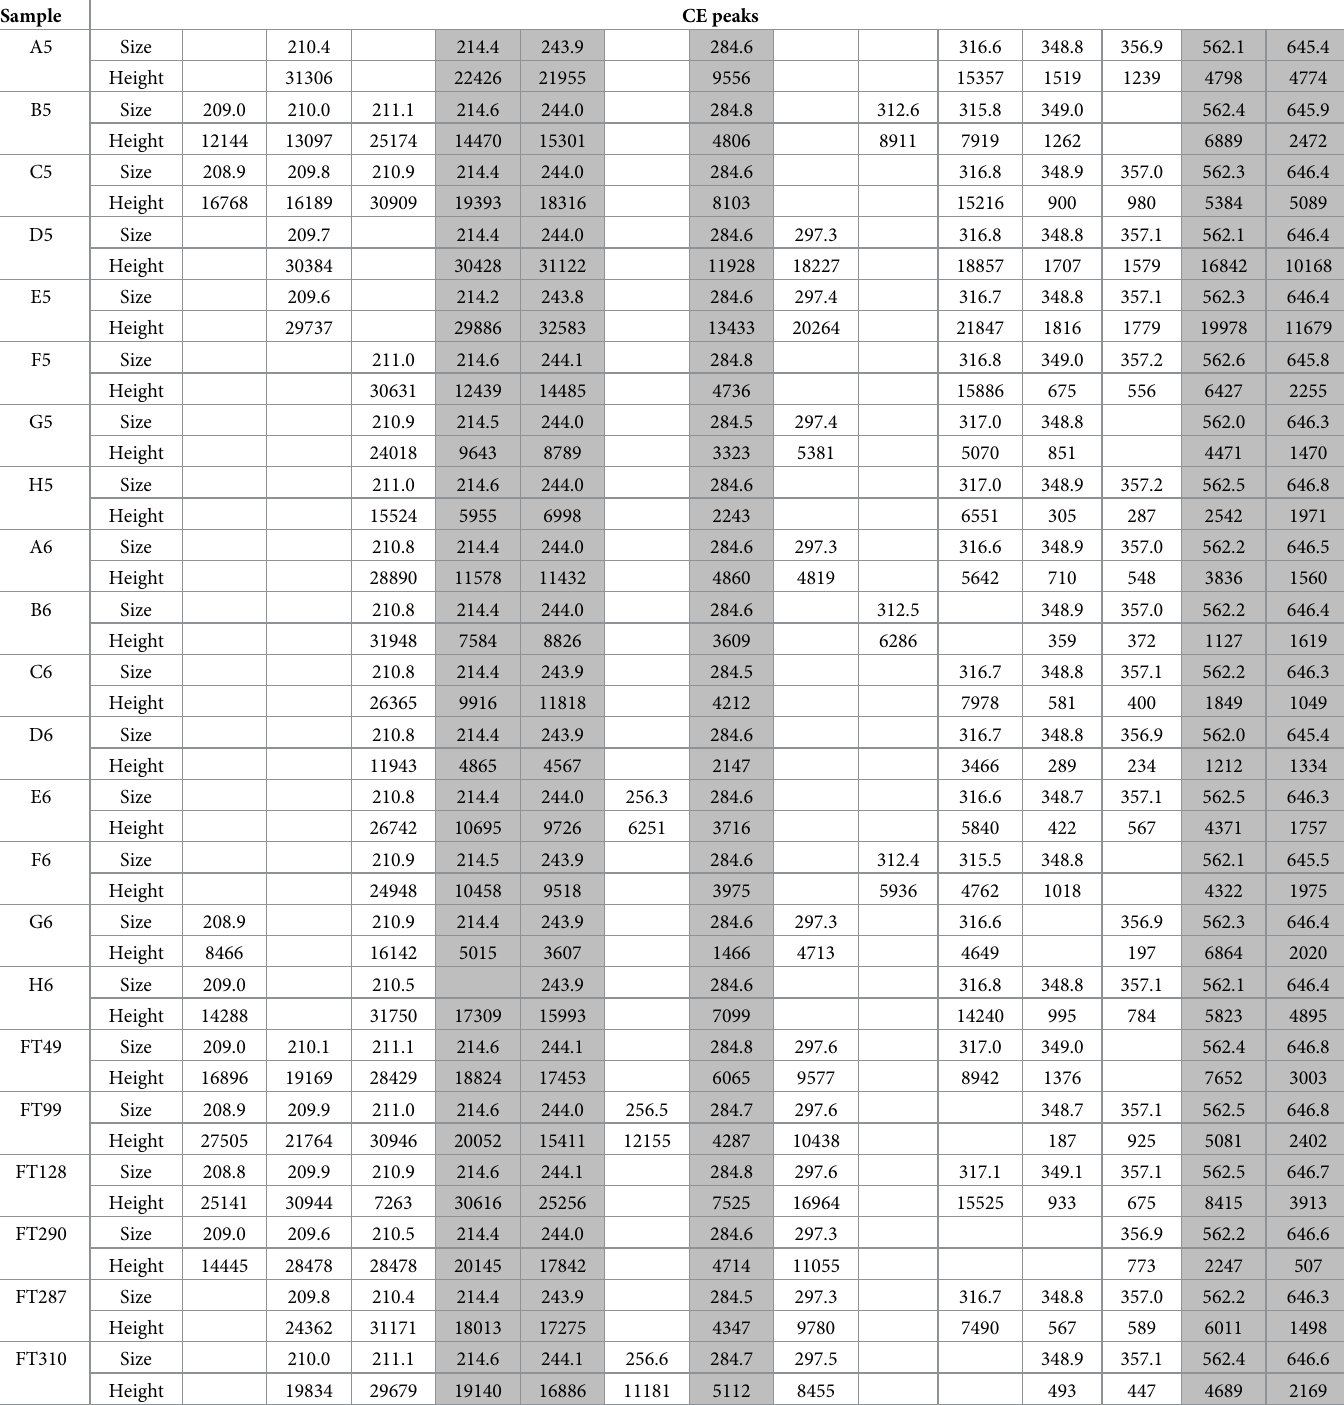
Table 1. aTBP profile of 22 samples of gilthead seabram ( S . aurata ).